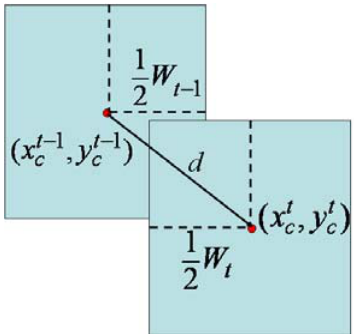
Figure 3. The spatial-temporal property of a moving